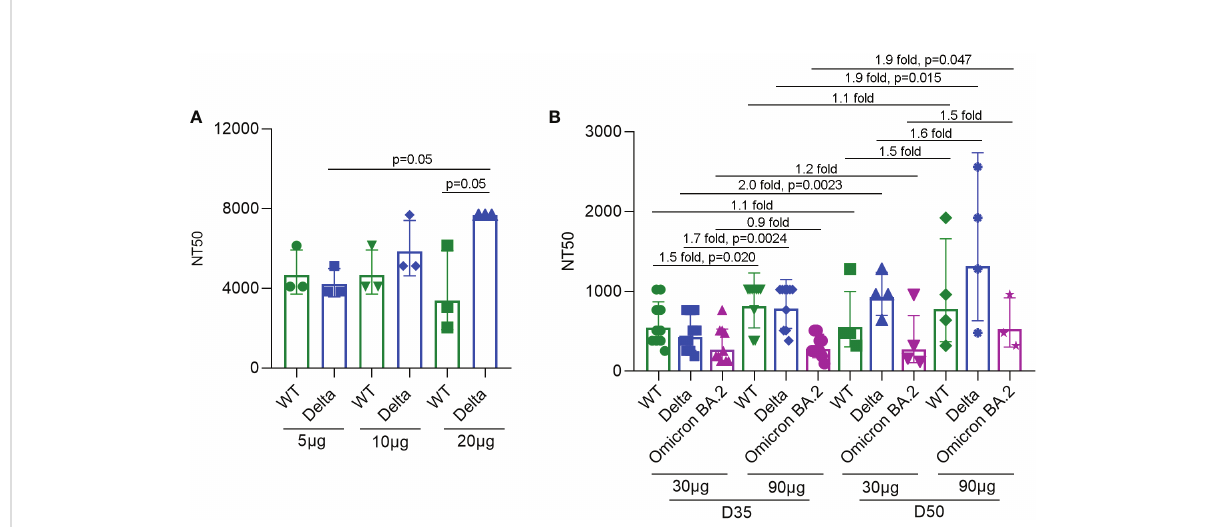
FIGURE 3 NT50s of neutralizing antibodies against the SARS-CoV-2 WT strain, as well as Delta and Omicron BA.2 variants under SYS6006 immunization. (A) 6-8-week-old female BALB/c mice were immunized intramuscularly with the indicated doses of SYS6006 and boosted with the same dose on day 21 post initial immunization. Sera were collected from mice 14 days after boost immunization. The serum samples from 3 or 4 mice were mixed and used to test NT50s of neutralizing antibodies against SARS-CoV-2 wild-type strain and Delta variant. (B) Cynomolgus macaques were intramuscularly immunized with the indicated doses of SYS6006 and boosted twice with a 21-day interval using the same dose. The sera were collected 35 days (D35) and 50 days (D50) after the initial vaccination. The NT50s of neutralizing antibodies in sera against SARS-CoV-2 WT strain, and Delta and Omicron BA.2 variants were determined. Data are presented as geometric mean ± geometric SD. NT50, neutralization titer with 50% inhibition of cytopathic effect, WT, wild-type. The fold changes and statistical signi fi cances between NT50s of corresponding groups were presented on the